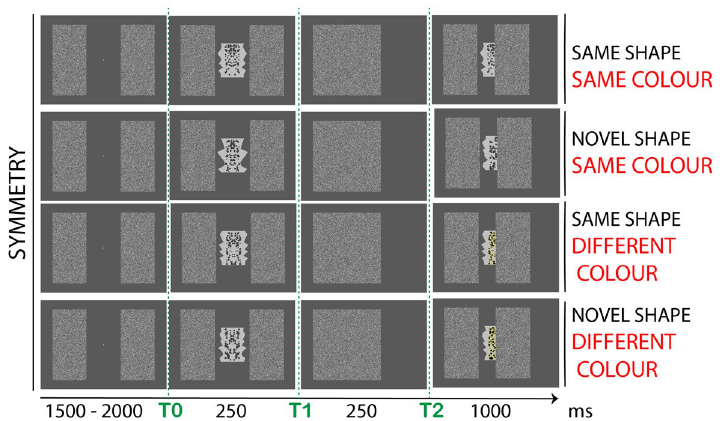
Figure 6. Experiment 3 experimental design was similar to Experiment 1. The shape in t2 could be either same as previously seen or novel. The additional factor was colour of the internal dot pattern, which could also be Same or Different in the two timewindows (counterbalanced across trials). Participants matched the colours and ignored the shapes. The figure illustrates the possible stimulus combination only for symmetry and right occluder displacement. The same combinations were presented for asymmetry and left occluder (counterbalanced across trials). The difference in colour was subtle (dark grey or black) to ensure participants’ engagement with the task. For illustrative purposes yellow contour lines have been added to the dot patterns (bottom rows) to highlight the difference in colour, but these were not present in the actual